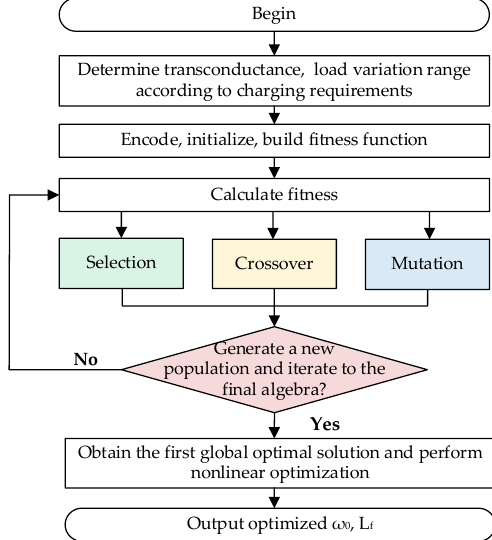
Figure 6. Flow chart of genetic algorithm. Table 2. Parameters Optimization of Genetic Algorithm.